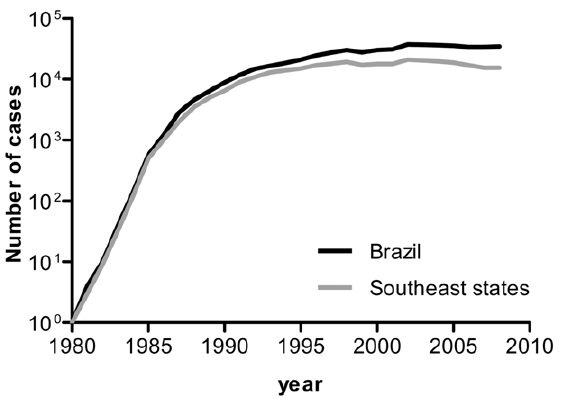
Table S2 Bayes Factors for testing the best-fit demo- graphic model for the Brazilian CRF28/29_BF-like HIV- 1 sequences. Figure 4. Number of new AIDS cases in Brazil. The number of new